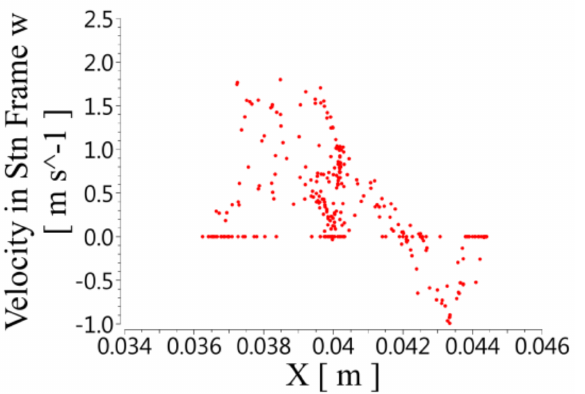
Figure 10. Distribution of axial velocity at different X positions on the XY plane.